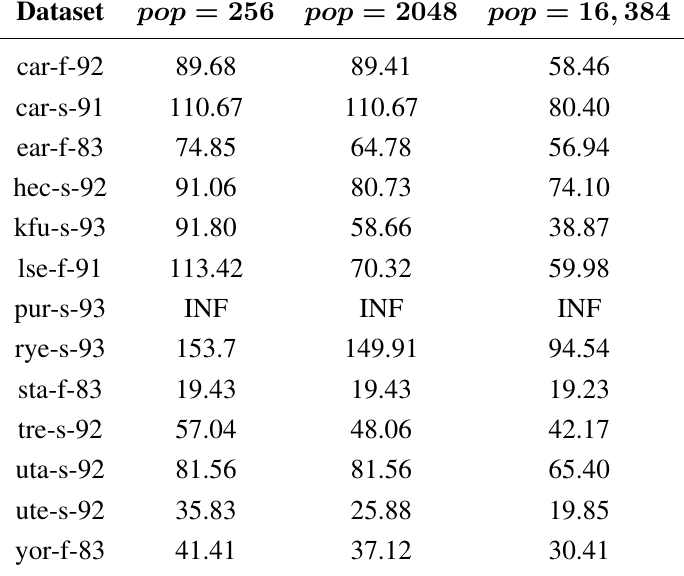
Table 4. Average distance (%) from the best reported solution in the bibliography with the genetic algorithm.